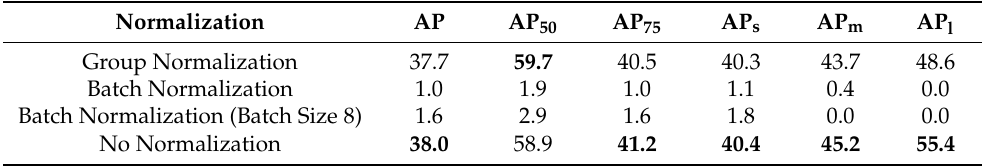
Table A1. Comparing ATSS with different normalization types in the head. Evaluation done with MMDetection. ATSS typically applies group normalization. However, group normalization is not supported by TensorRT 6. Thus, we evaluate batch normalization and applying no normalization as alternatives. However, batch normalization is not working at all even if the batch size is